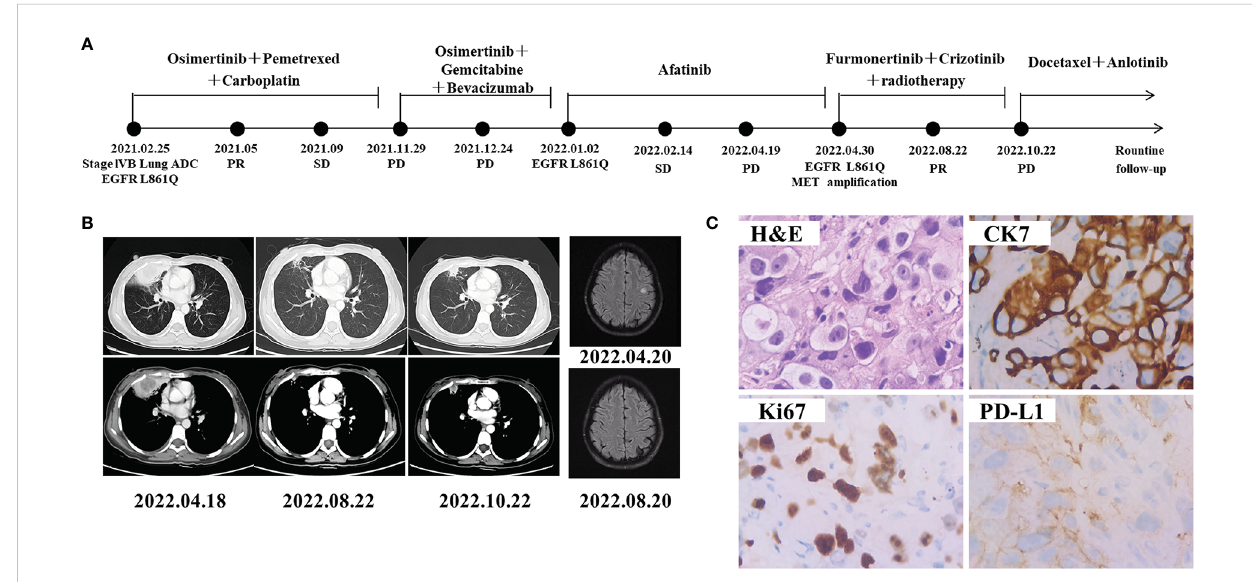
FIGURE 2 Schematic of treatment history of Case 2. (A) The timeline of treatment. (B) Chest CT images and brain MRI throughout the disease course. (C) Pathological examination of the surgical specimen. IHC testing (400×) results showed positive expression of CK7, PD-L1 and Ki67.